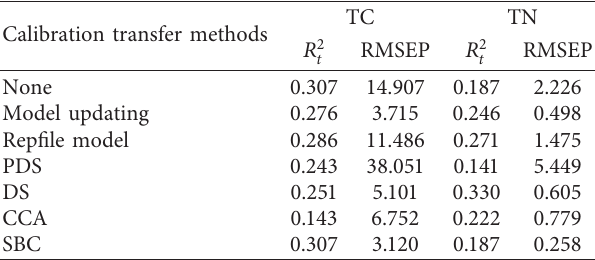
Table 3: Prediction results of soil TC and TN concentration by different calibration transfer